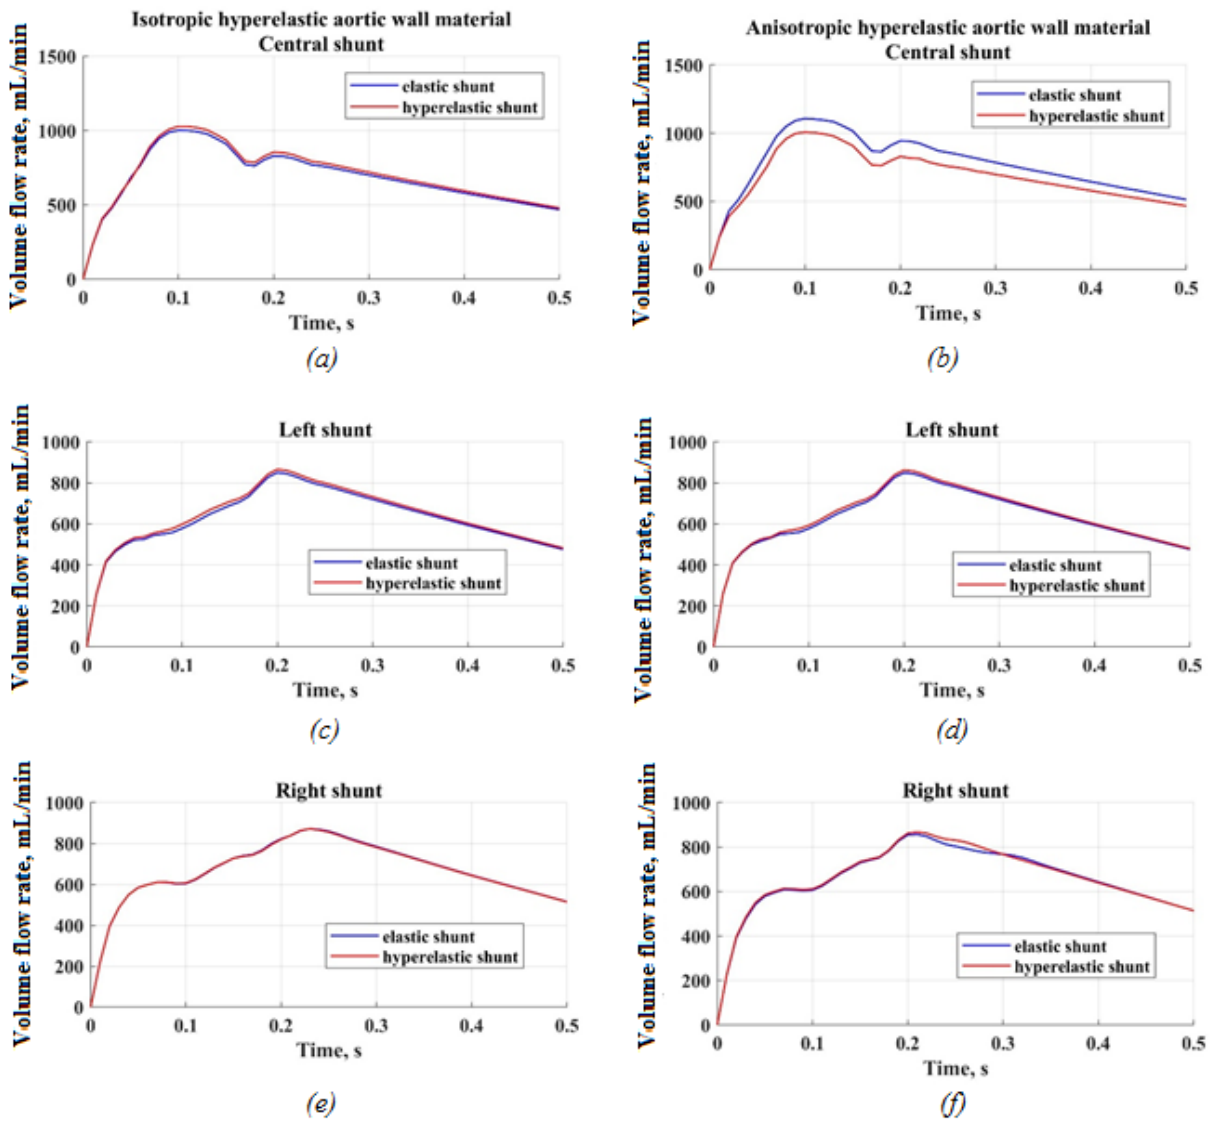
Figure 15. Flow rate through the shunt: ( a ) central shunt case (isotropic aortic wall), ( b ) central shunt case (anisotropic aortic wall), ( c ) left shunt case (isotropic aortic wall), ( d ) left shunt case (anisotropic aortic wall), ( e ) right shunt case (isotropic aortic wall), ( f ) right shunt case (anisotropic aortic wall).